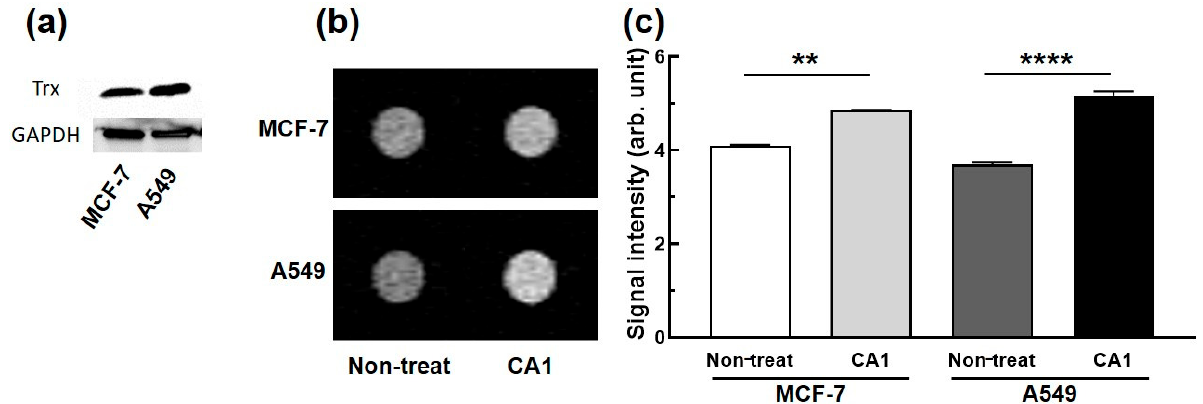
Figure 4. ( a ) Western blot analyses of Trx expression levels in MCF-7 and A549 cells, ( b ) representative T 1 -W MR phantom images of MCF-7 and A549 cells treated with CA1 (100 µM) at 4.7 T, and ( c ) a quantitative comparison of the MR signal intensities (study replicated in three independent experiments). **, p < 0.01; ****, p < 0.0001 (Student’s t-test ).